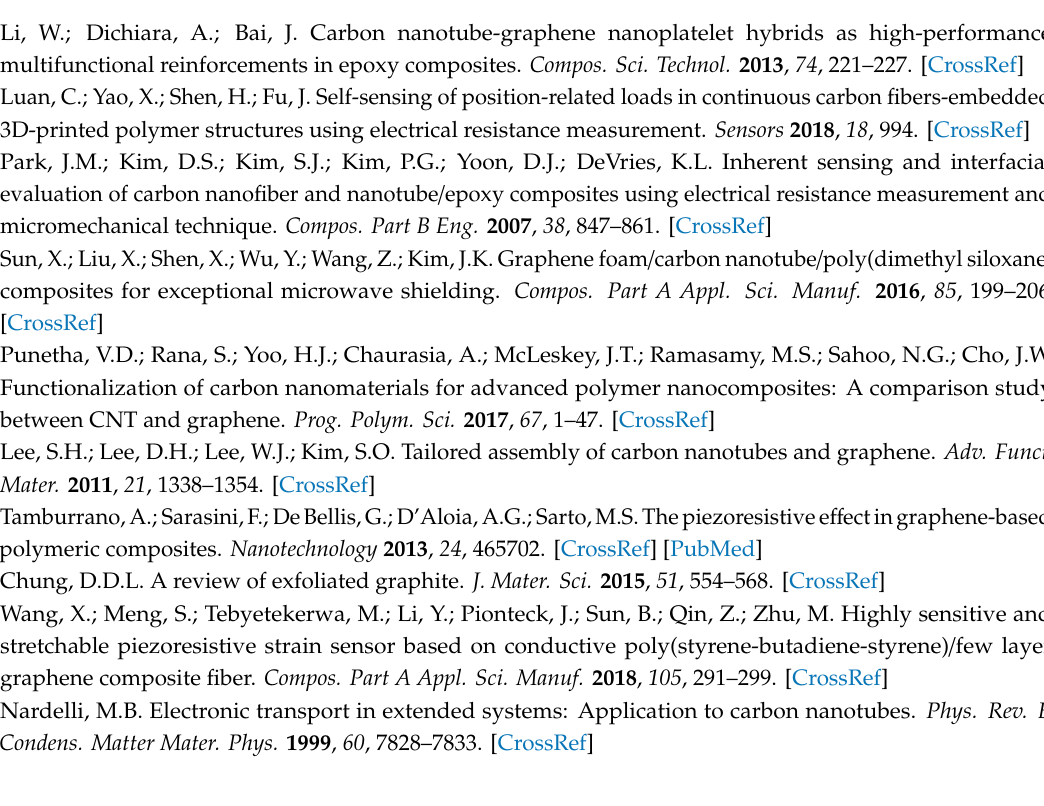
Figure S1: A SEM image of as-received CNTs provided by the manufacturer., Figure S2: A SEM image of as-received graphene provided by the manufacturer., Figure S3: SEM images of as-received graphite nanoplatelet provided by the manufacturer., Figure S4: Electrical resistance change rates and applied stress simultaneously determined under repetitive tensile loadings., Figure S5: Schematics of carbon nanomaterials network at ( a ) a content ratio adjacent to percolation threshold and ( b ) a content ratio far greater than percolation